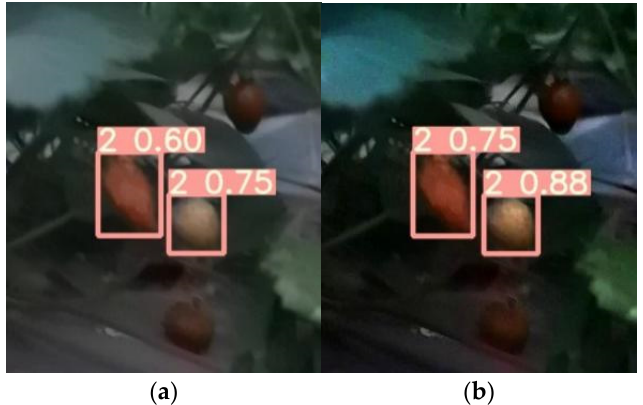
Figure 6. Comparison of the test results. ( a ) Test results for unenhanced images; ( b ) Test results of the enhanced image.